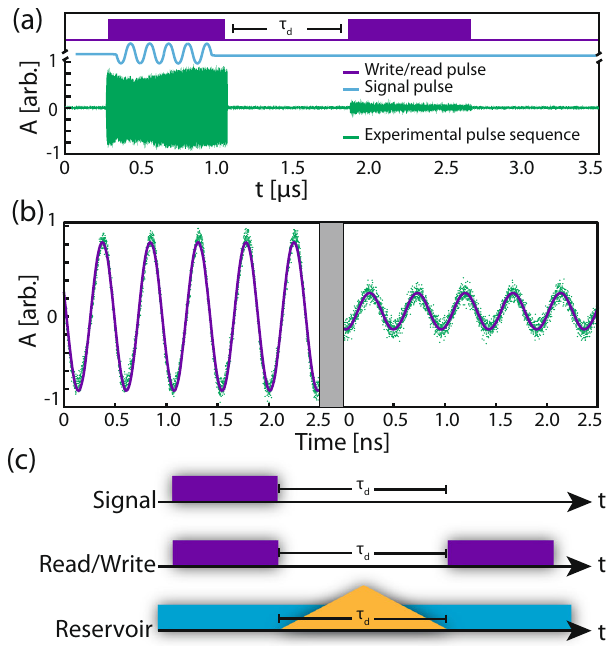
Fig. 6 Pulse-storage measurement procedure. a Timing diagram for optomechanical pulse storage, along with an example of a typical measure signal (purple). b Detail of a short section of the write (left panel) and read pulse (right panel). c Timing diagram for the storage enhancement and phase-manipulation experiments described in the main